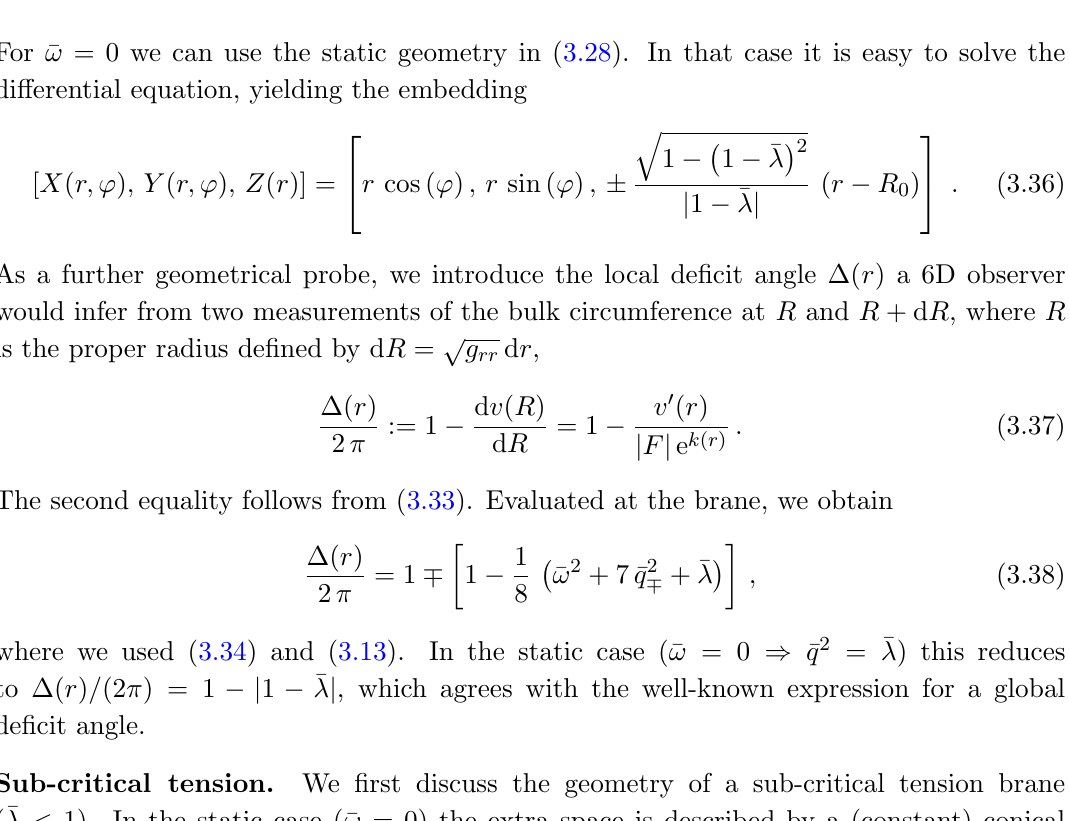
Figure 5 . Embedding diagrams of the extra space geometry. The interior (green) is (cid:13)at whereas the exterior (blue or red) features a conical de(cid:12)cit and is curved for (cid:22) ! 6 =